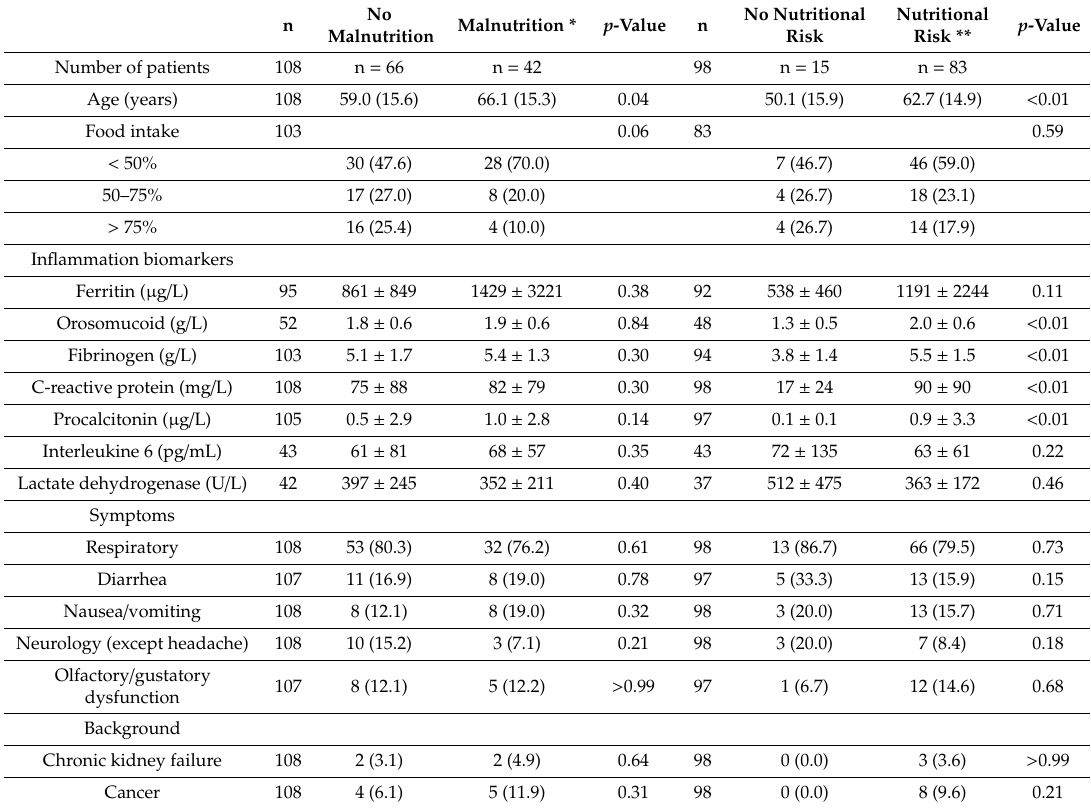
Table 3. Causes of malnutrition and nutritional risk.